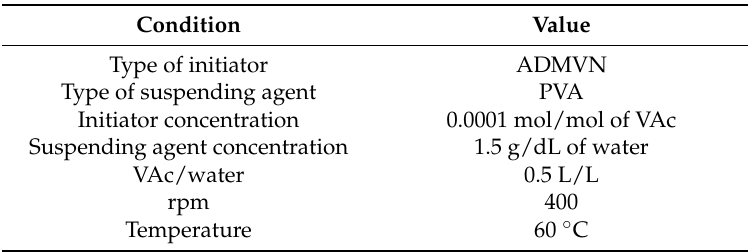
Table 1. Reaction conditions for the suspension polymerization of